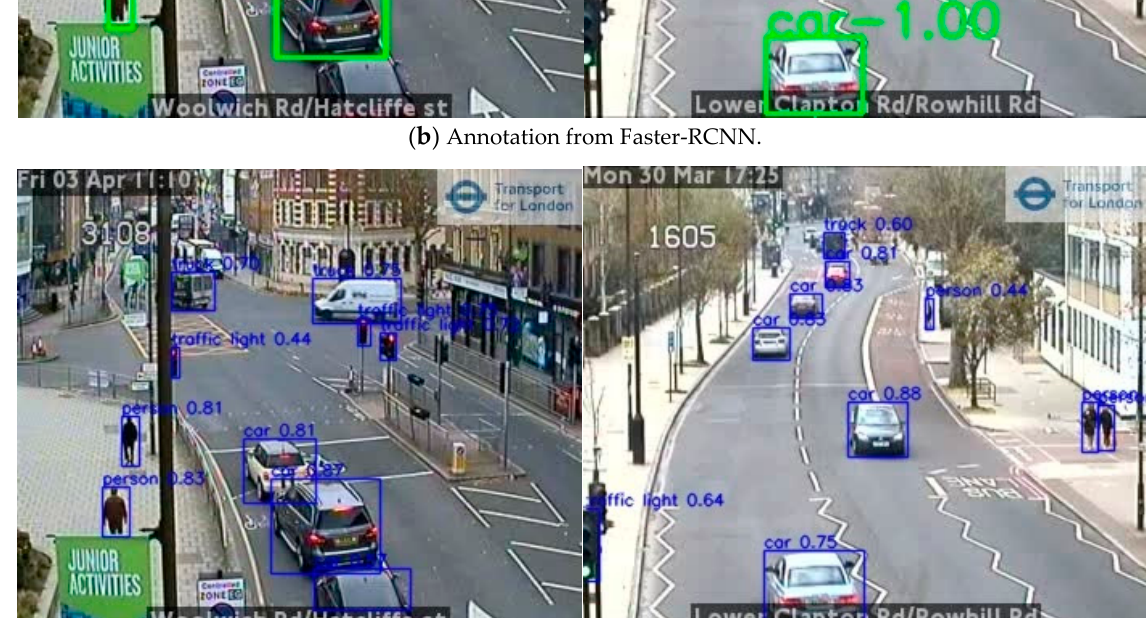
from London (images TfL Open Data). ( a ) Annotation from Google Vision API, ( b ) annotation from Faster-RCNN, ( c )